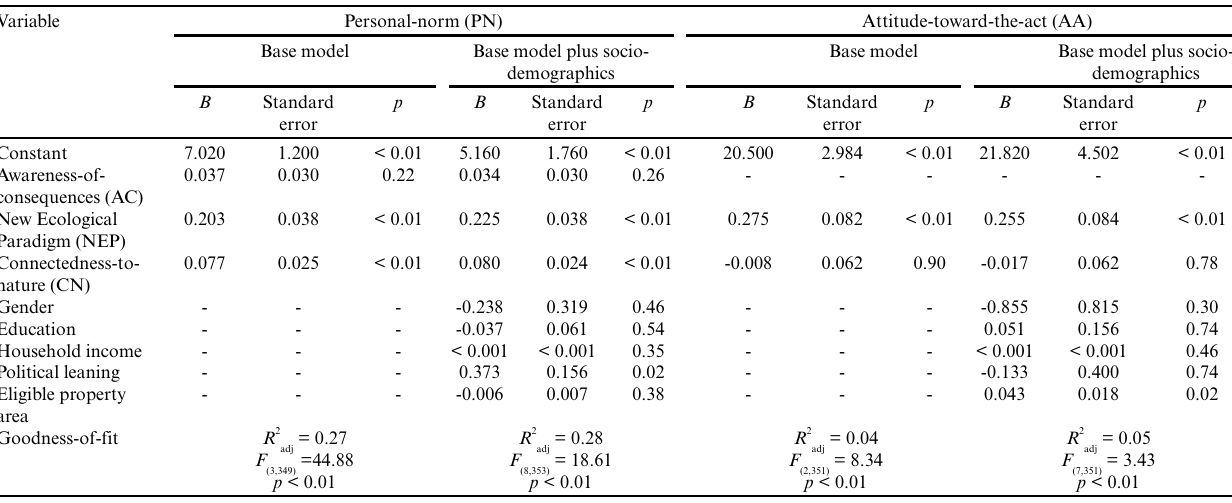
Table 4 . Attitude-behavior models of norm activation and reasoned